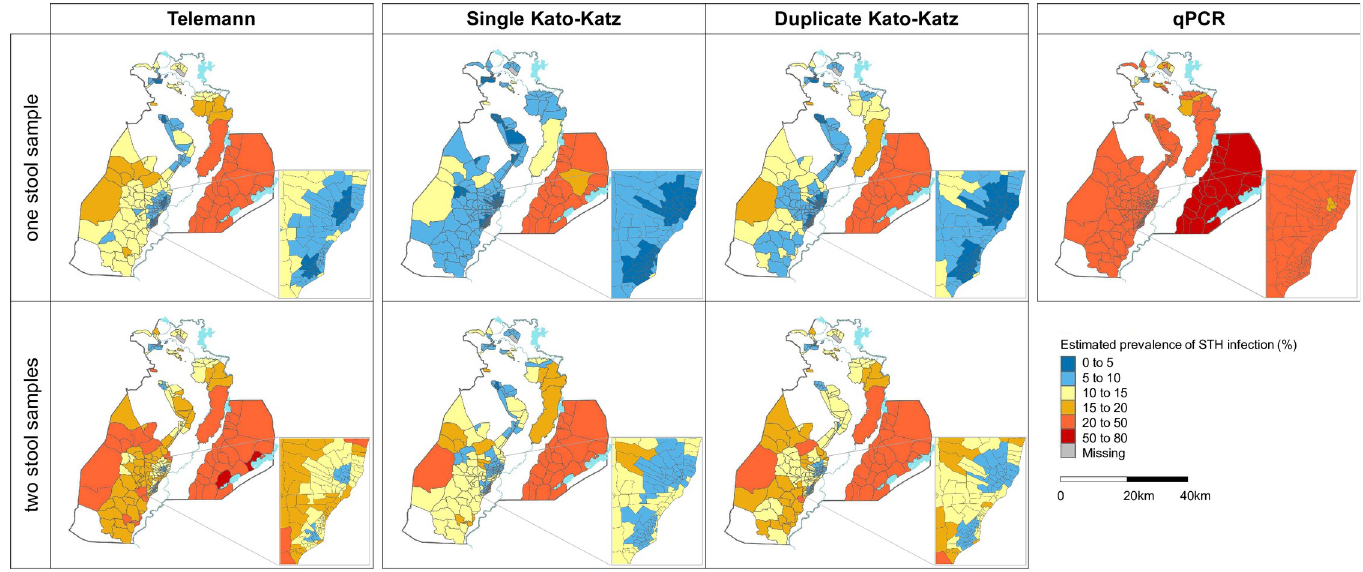
Fig 4. District map of the estimated prevalence of at least one STH infection calculated with a generalized linear model assuming a binomial distribution for Telemann in one and two stools, single and duplicate Kato-Katz in one stool, single and duplicate Kato-Katz in two stools and qPCR in one stool. Base layer map obtained in https://data.humdata.org/dataset/mozambique-administrative-levels-0-3.